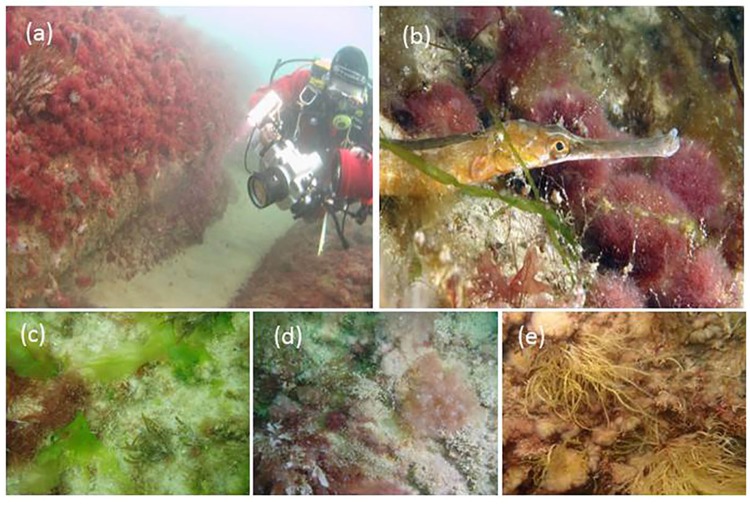
The Artificial Surf Reef.(a) South-eastern corner of the Artificial Surf Reef in June 2010. The upper red alga turf is dominated by non-native alga Asparagopsis armata (Falkenbergia stage). Close to the sea bed the reef is scoured, with scattered ascidians including Styela clava.; (b) Greater pipefish (Syngnathus acus) amongst red alga Asparagopsis armata. Photos (c-e) from point on south-east corner: (c) 4/6/2011 with Ulva lactuca, Cladostephus spongiosus, Halurus flosculosus; (d) 7/9/2012 with Cryptopleura ramosa, filamentous red algae and bryozoans) (e) 12/9/2013 with Gracilaria gracilis and Asparagopsis armata (Falkenbergia stage) (All photos KC, except photo (b) S Trewhela).